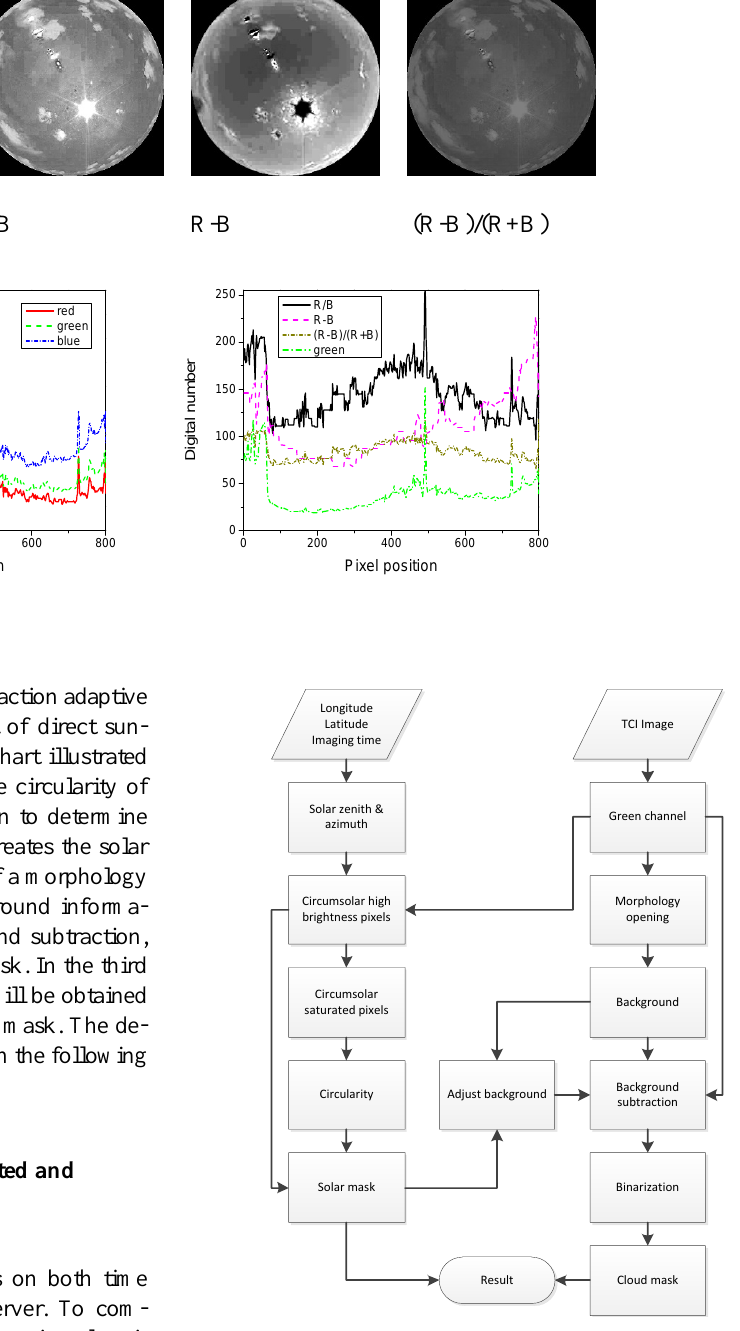
Figure 4. Flow chart of the proposed